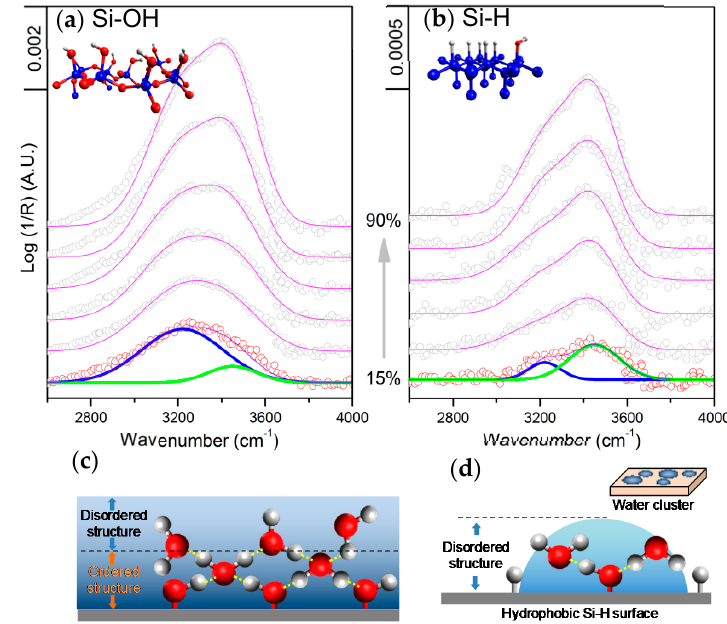
Figure 5. Water adsorptions on hydrophilic OH-terminated silicon oxide surface and hydrophobic H-terminated silicon surface. ATR-IR spectra of the O-H stretching region of water adsorbed on ( a ) hydrophilic OH-terminated silicon oxide surface (Si-OH) and ( b ) hydrophobic H-terminated silicon surface (Si-H) at relative humidity (RHs) of 15%, 30%, 45%, 60%, 75% and 90%. The insets schematically show the Si-OH functional groups on a native oxide layer and the Si-H groups on the HF-etched surface. Si: blue, O: red, H: grey. The O-H stretching region is fitted with two components-strongly H-bonded water (blue lines centered at 3200~3275 cm − 1 ) and weakly H-bonded water (green lines centered at 3400~3450 cm − 1 ). ( c ) and ( d ) respectively illustrating the schematic of structural of adsorbed water layer on hydrophilic Si-OH and hydrophobic Si-H surfaces. The dotted yellow lines represent hydrogen bonds. Note that illustration is not to scale. Upper-right inset in ( d ) showing the schematic of clusters of water molecules on the hydrophobic Si-H surface. Reprinted from Ref. [41], Copyright 2018, with permission from ACS